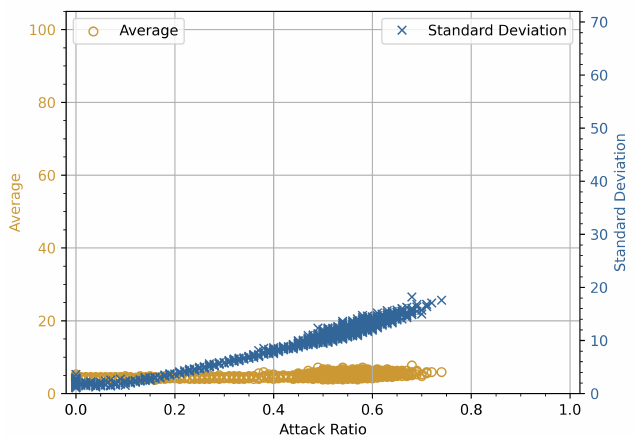
Figure 3. Experimental results of attack ratio vs. average and standard deviation for DoS attack.